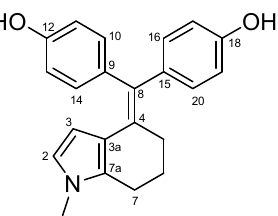
Scheme 17. Structure of 31 with the numbering of atoms used for the assignment of NMR data.